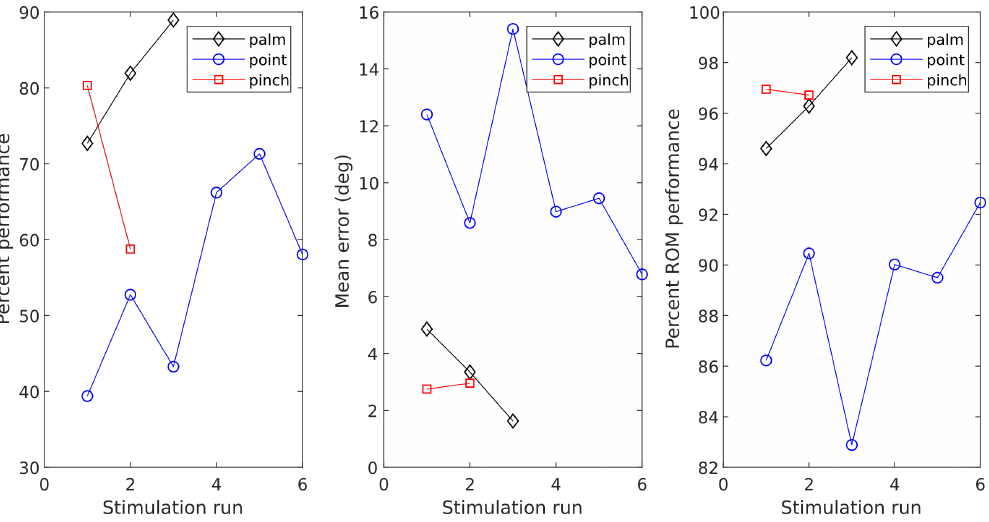
Figure 10. Graph showing reduction in error by iterative improvement of stimulation profile for the three different gestures.